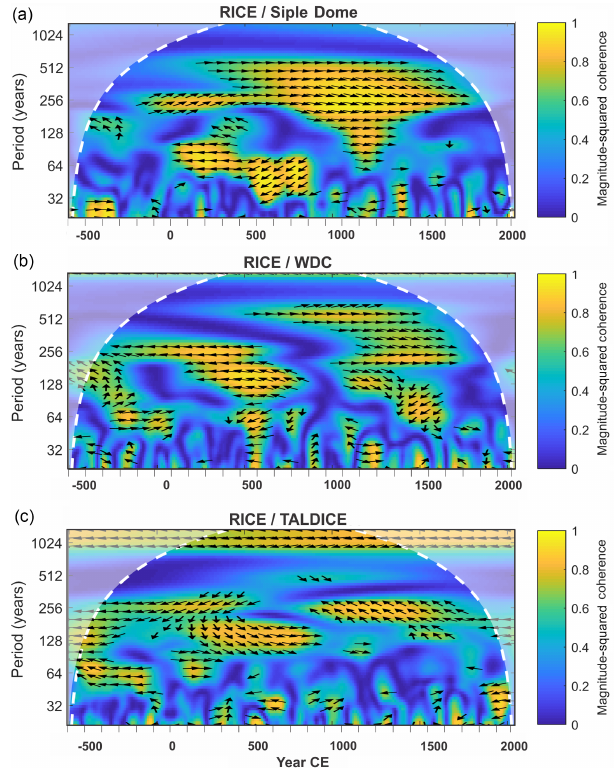
Figure 9. Wavelet coherence and cross spectrum analysis of (a) RICE δ D and Siple Dome δ 18 O, (b) RICE δ D and WDC δ 18 O, and (c) RICE δ D and TALDICE δ 18 O. The analysis was conducted on decadally averaged, detrended data, smoothed with a 200-year mov- ing average. The coherence is computed using the Morlet wavelet and is expressed as magnitude-squared coherence (msc). The phase of the wavelet cross-spectrum is provide for values over 0.6msc us- ing Welch’s overlapped averaged periodogram method (Kay, 1988; Rabiner et al., 1978). Arrows to the right indicate RICE is leading; arrows to the left indicate RICE is lagging. An upward or downward arrow represents quarter cycle